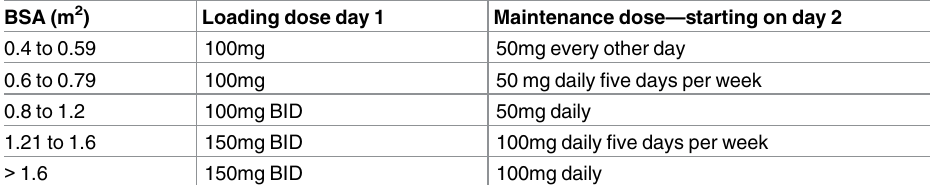
Table 2. Perifosine dose level 2 (~50 mg/m 2 /day).